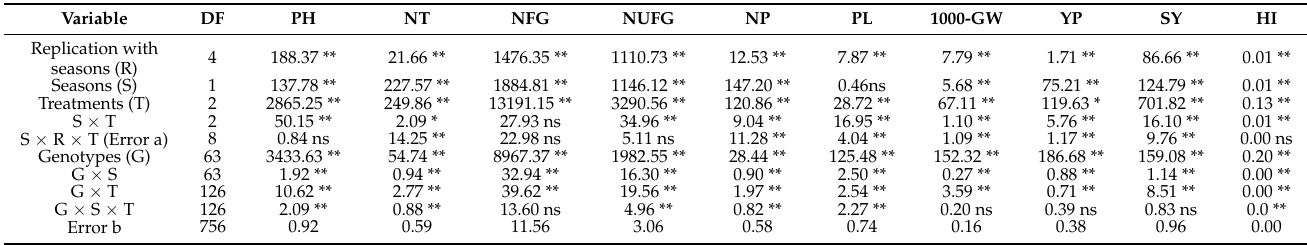
Table 4. Pooled analysis of variance mean square of growth traits across two planting